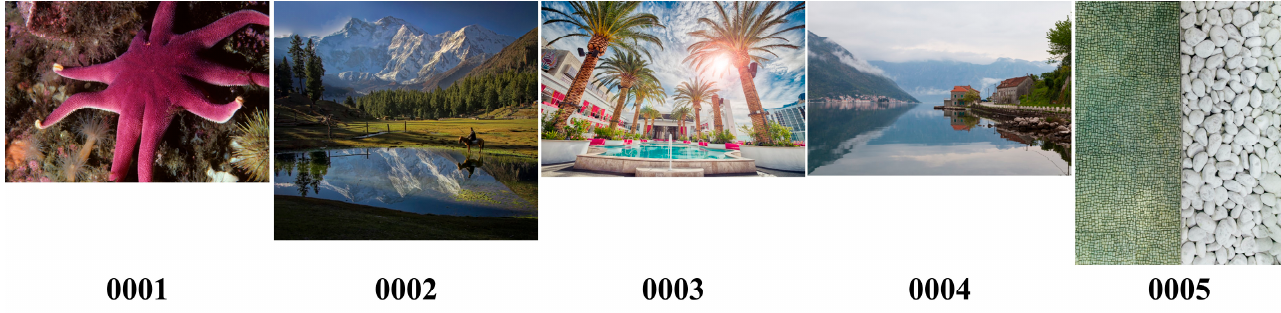
10 of 17 Table 2. BRISQUE, SSIM measuring result: typical image set.